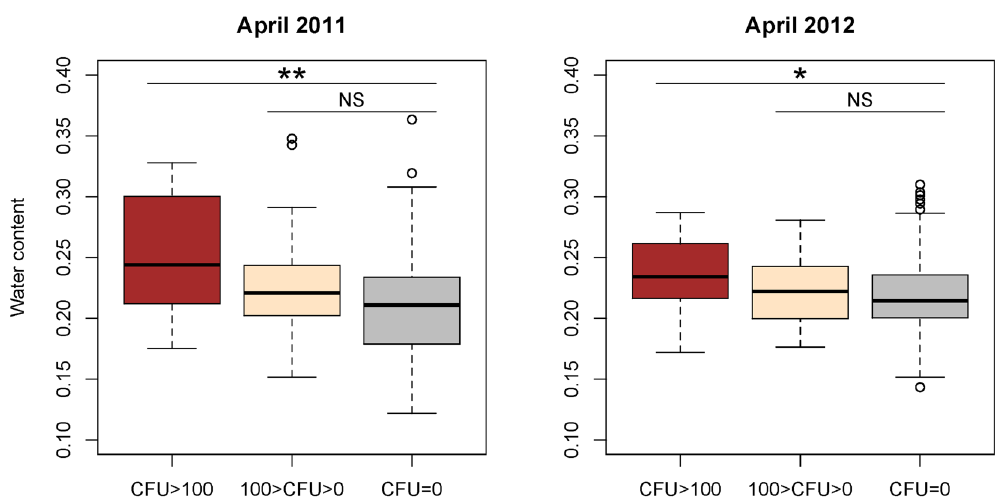
Figure 2. Box-whisker plots of soil water content of samples in which B. pseudomallei was abundant (CFU > 100), present (100 > CFU > 0), or absent (CFU = 0) in April 2011 and April 2012. Refer to Fig. 1 for the explanation of Box–whisker plots. * P ≤ 0.05, ** P ≤ 0.005 and NS = Not